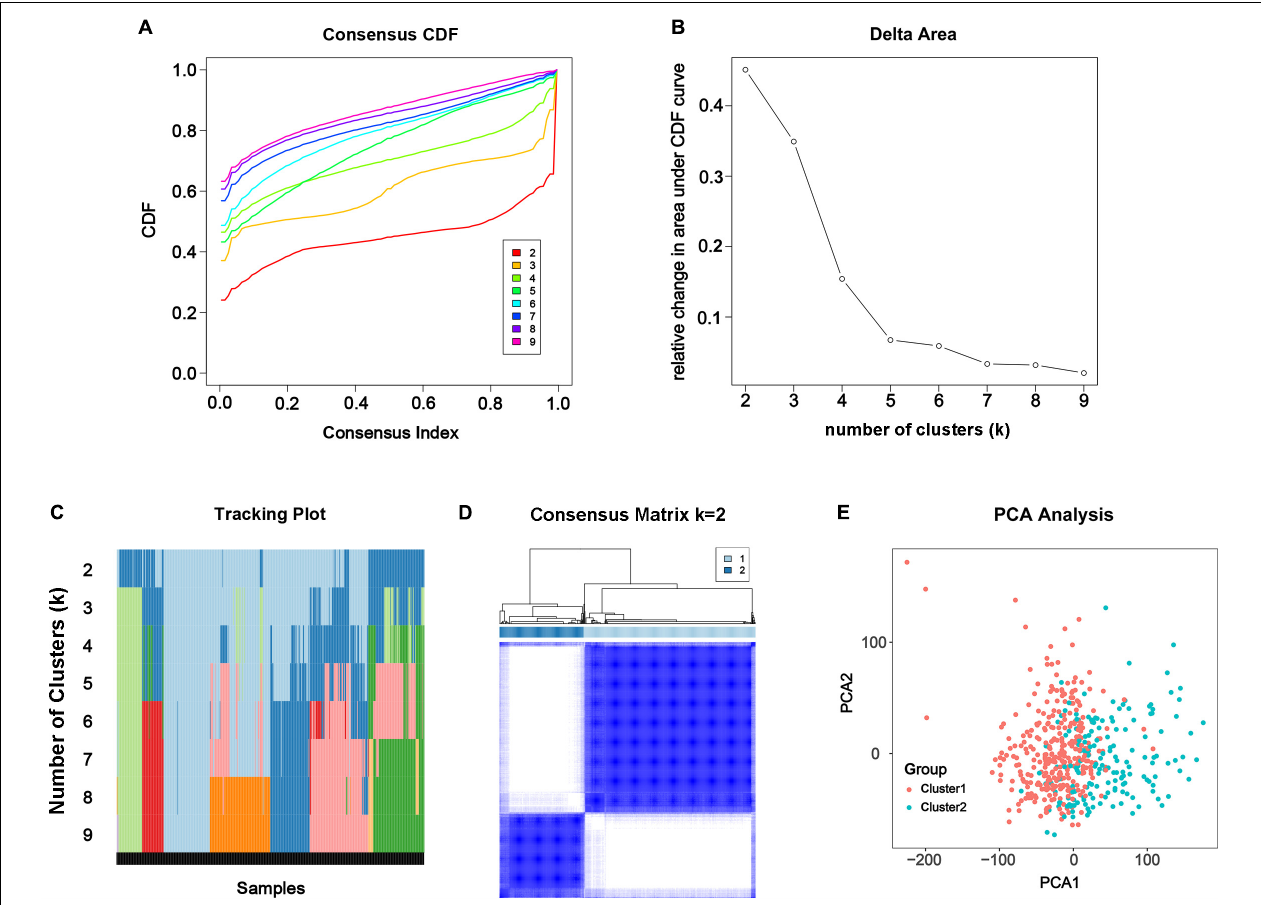
FIGURE 3 | Consensus clustering of the tumorous cohort from TCGA-PRAD based on the differently expressed m 6 A regulatory genes. (A) Consensus clustering distribution function (CDF) for k = 2 to 9. (B) Area under CDF curve increment for k = 2 to 9. (C) Tracking plot for k = 2 to 9. (D) Consensus matrix for optimal k = 2. (E) Principal components analysis (PCA) of the total transcriptomic profile from TCGA-PRAD cohort for optimal k =